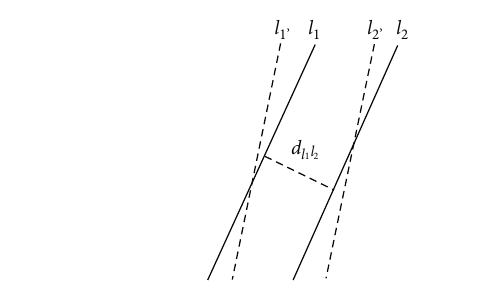
Figure 8: 3D histogram of the occurrence relative frequency of the structural plane of the two groups of rocks.